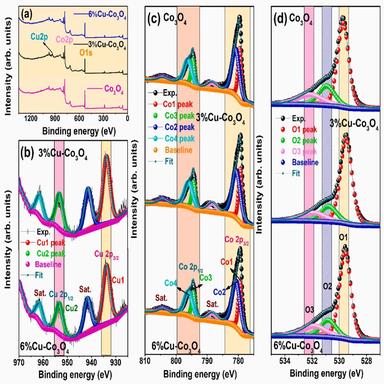
Comparison of XPS survey (a), core-level Cu 2p (b), Co 2p (c), and O 1s (d) of the Co3O4, 3%Cu–Co3O4, and 6%Cu–Co3O4.